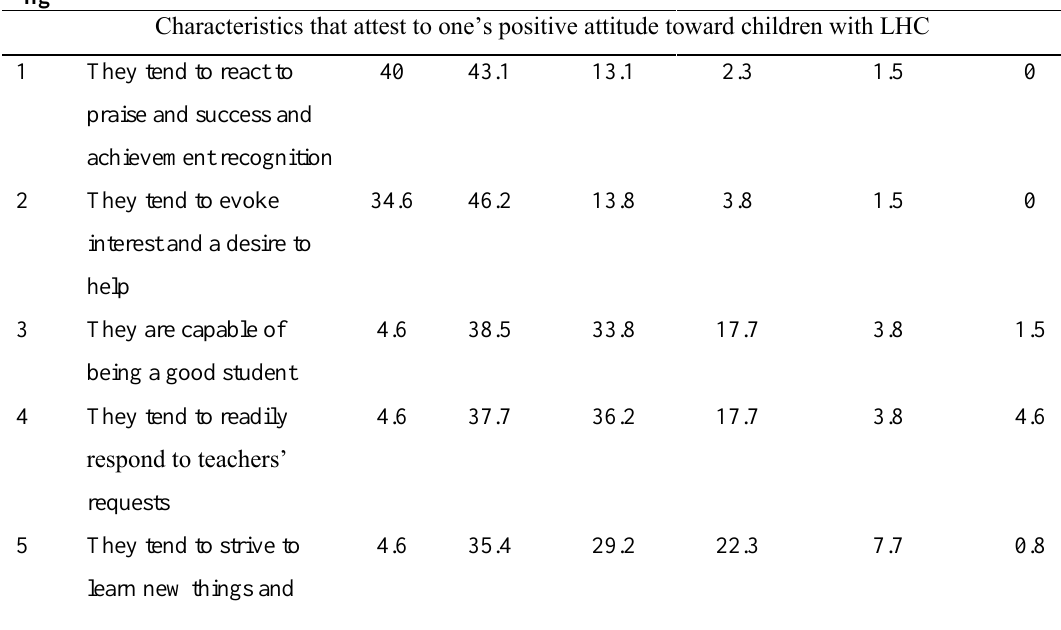
Table 2. Teacher Perceptions of Learners with LHC Ra nki Learner ng